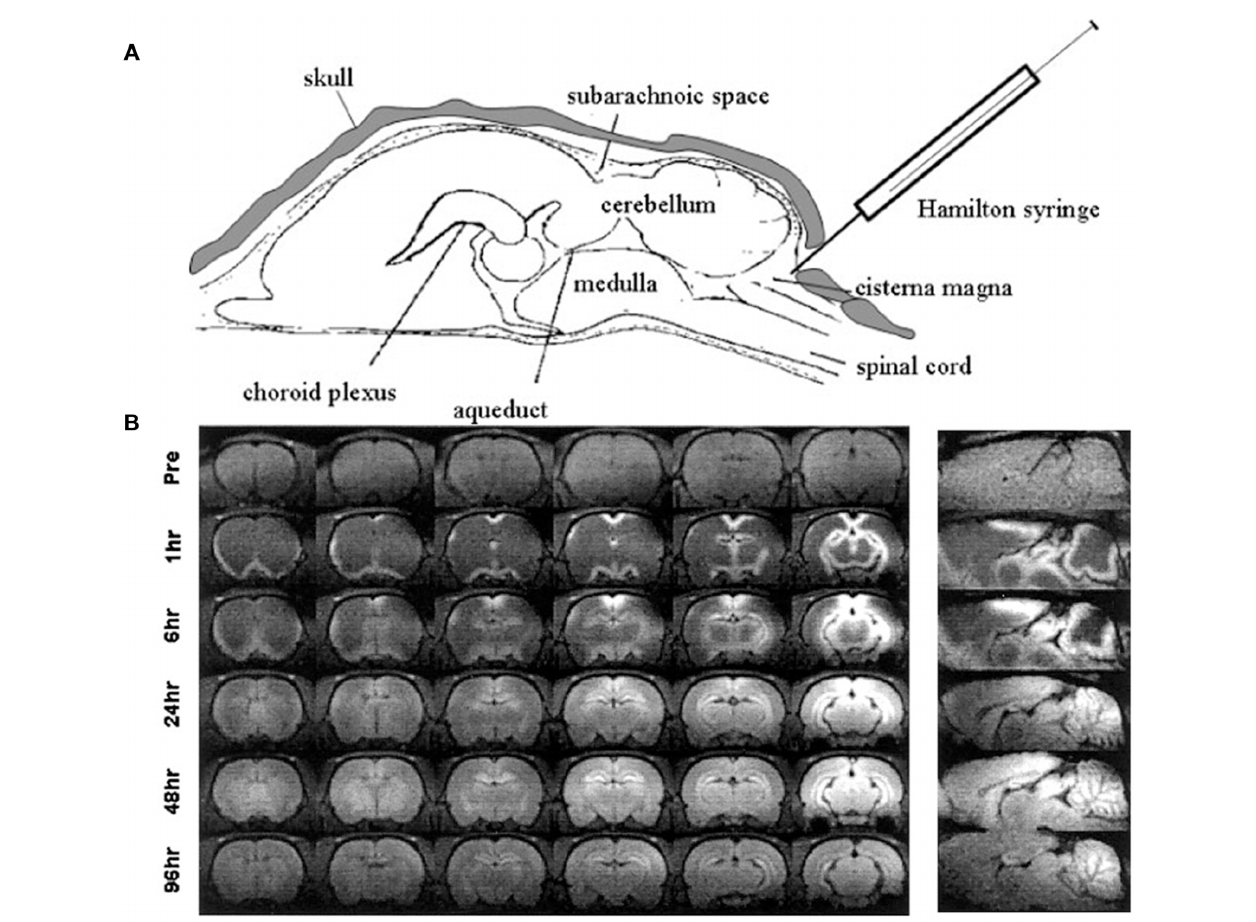
FIGURE 4 | Intrathecal injection of manganese chloride. Adapted with permission from Liu et al. (2004). (A) Injection scheme for intrathecal manganese injection. (B) Serial images show the spread of enhancement from the ventricles throughout the cortex, subcortex, and cerebellum.